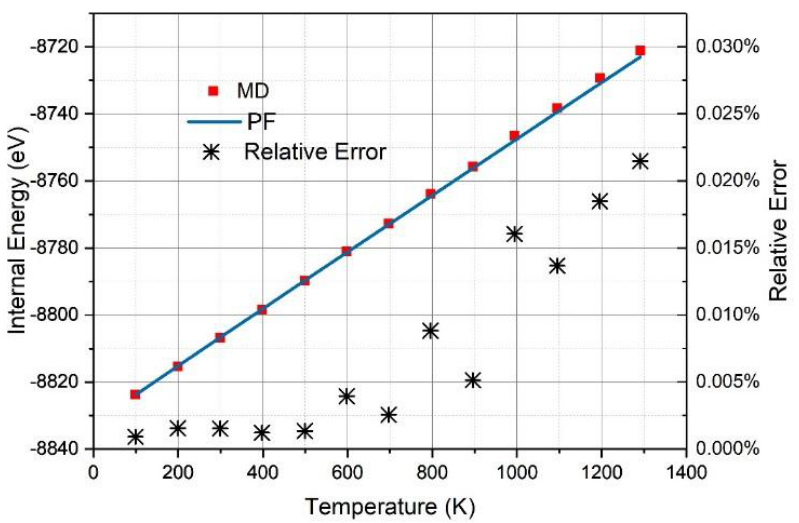
Figure 6. The internal energy as a function of temperature derived from the PF (blue line) or MD simulation (red square), where the relative errors ∣𝑬 𝑷𝑭 −𝑬 𝑴𝑫 ∣ the right vertical axis.